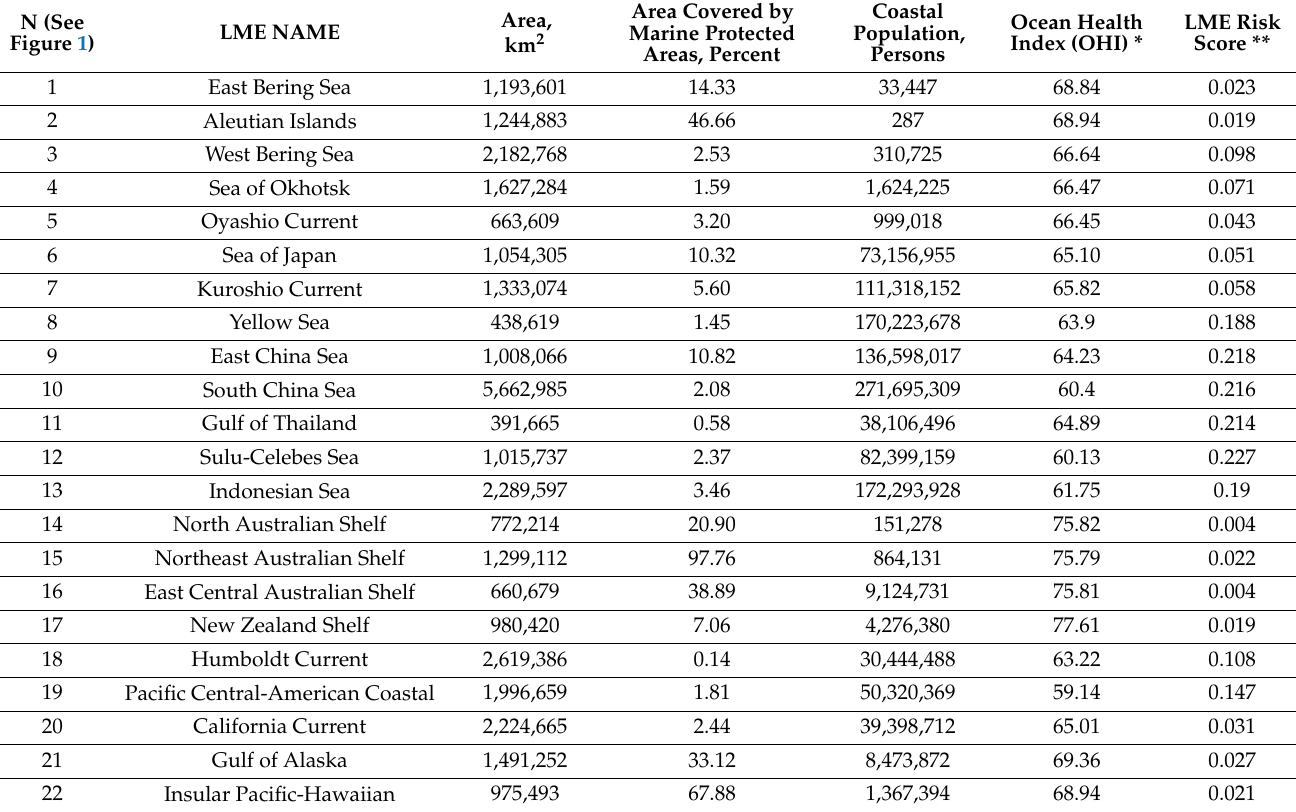
Table 1. Large marine ecosystems of the Asia-Pacific region (source of data used: